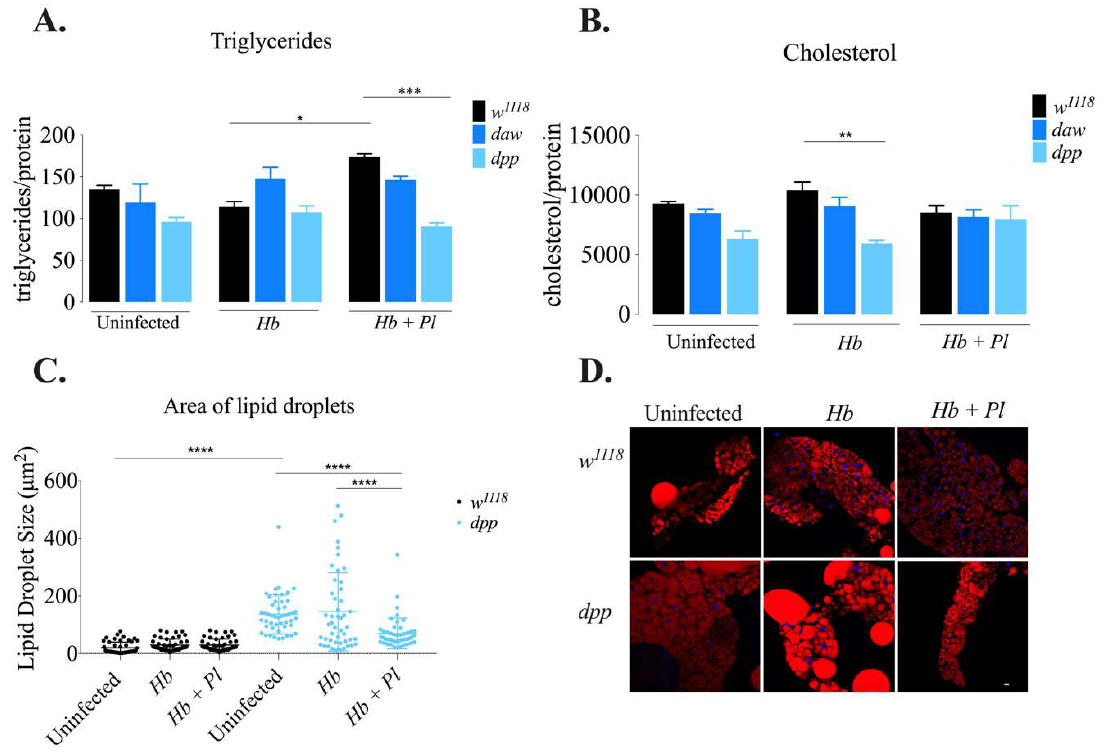
Figure 4. Lipid metabolism in Drosophila melanogaster TGF-β mutant larvae 24 h after infection with axenic ( Heterorhabditis bacteriophora , Hb ) or symbiotic ( Heterorhabditis bacteriophora + Photorhabdus luminescens , Hb + Pl ) nematodes. ( A ) Triglyceride levels in TGF-ß mutant larvae infected with parasitic nematodes. Triglyceride content in dpp mutant larvae significantly decreases after infection with H. bacteriophora symbiotic nematodes compared to background control ( w 1118 ) larvae (*** p = 0.0004). In addition, following symbiotic H. bacteriophora infection, level of triglycerides increase in background control ( w 1118 ) larvae compared to larvae infected with axenic nematodes (* p = 0.0164). ( B ) Cholesterol levels in TGF-ß mutant larvae infected with parasitic nematodes. Cholesterol content is reduced in dpp mutants infected with axenic H. bacteriophora compared to background control larvae (** p = 0.0038). ( C ) Size of lipid droplets in the fat body of D. melanogaster dpp mutant larvae 24 h after infection with H. bacteriophora axenic or symbiotic nematodes (**** p < 0.0001). ( D ) Confocal microscopy images of lipid droplets stained with Nile Red (red) and DAPI (blue) in the fat body of H. bacteriophora -infected or uninfected D. melanogaster dpp mutant larvae and their background controls ( w 1118 ). Scale bar is 10 microns. Triglyceride and cholesterol quantification experiments were performed in biological duplicates and repeated three times ( N = 42–54). Lipid droplet staining was performed by measuring the four largest lipid droplets per cell from four fat body